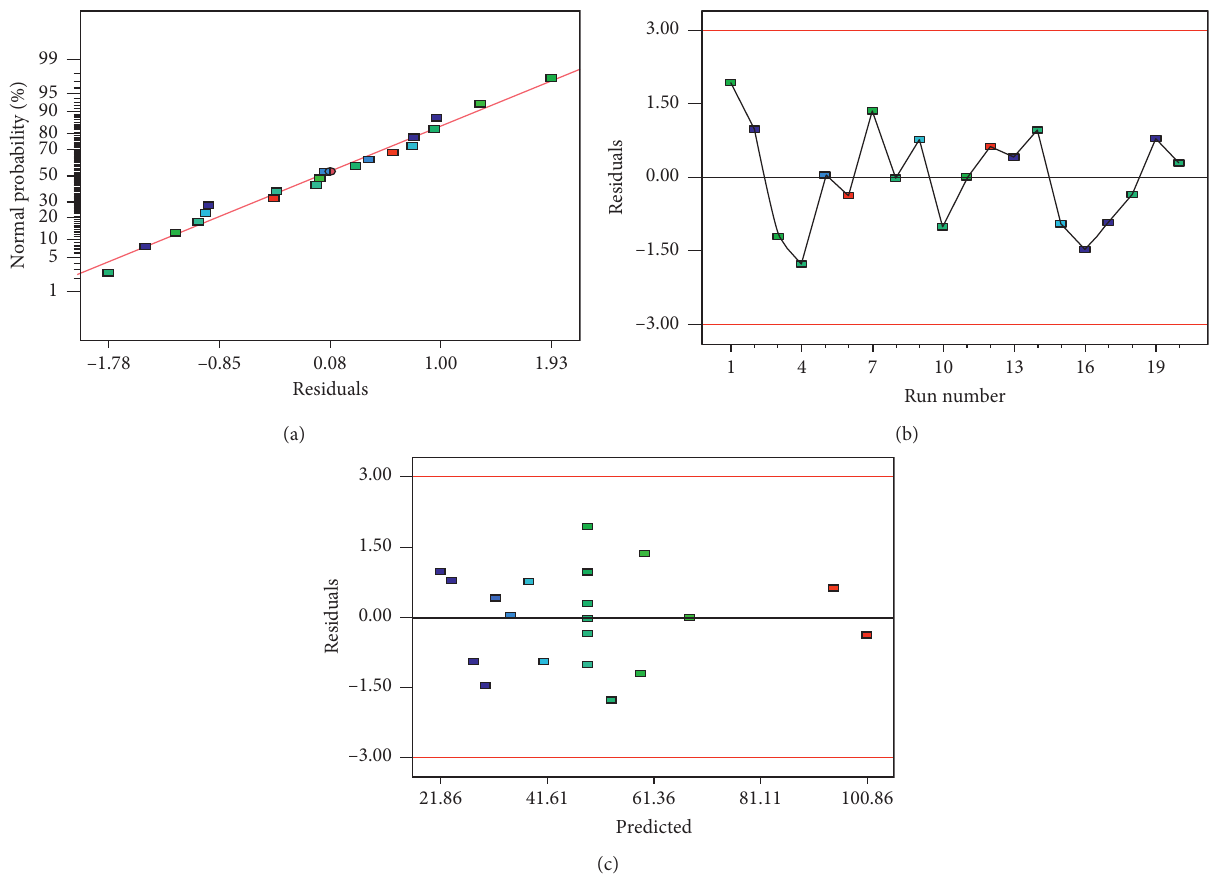
Figure 3: Residual plot for WML. (a) Normal probability plot. (b) Residuals versus run number. (c) Residuals versus predicted